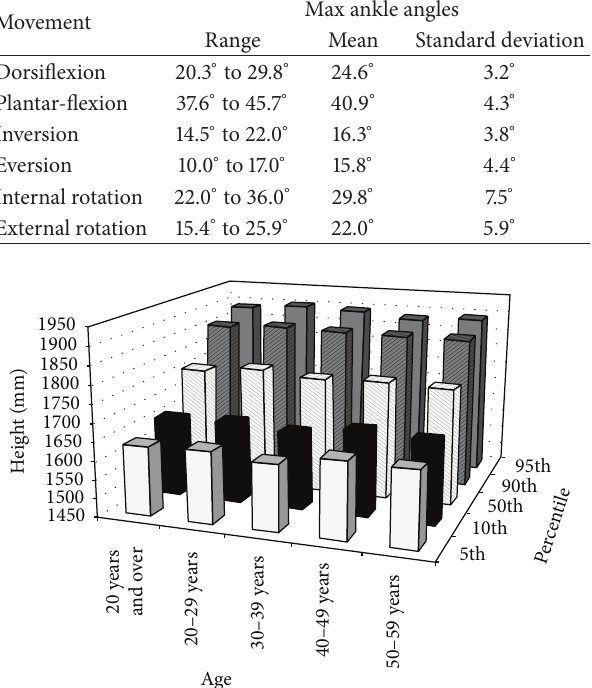
Figure 3: Height in millimeters for males by age and selected